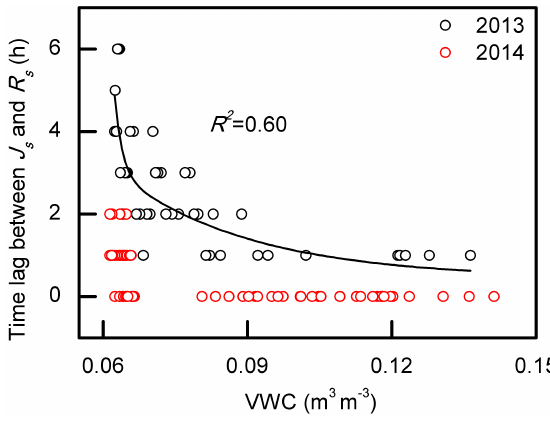
Figure 9. Time lag between sap flow per leaf area ( J s ) and short wave radiation ( R s ) in relation to volumetric soil water content (VWC). Hourly data in non-rainy days during the mid-growing sea- son of 1 June to 31 August 2013 and 2014. The lag hours were cal- culated by a cross-correlation analysis using a 3-day moving win- dow with a 1-day time step. Rainy days were excluded. The solid line is based on an exponential regression ( p < 0.05).